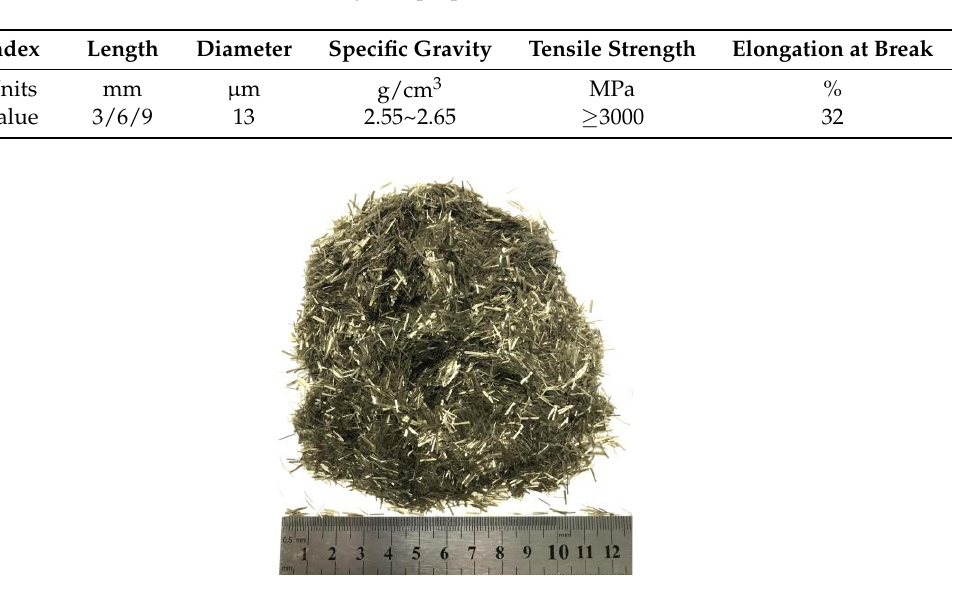
Figure 1. Morphology of basalt fiber with length of 6 mm in this study.